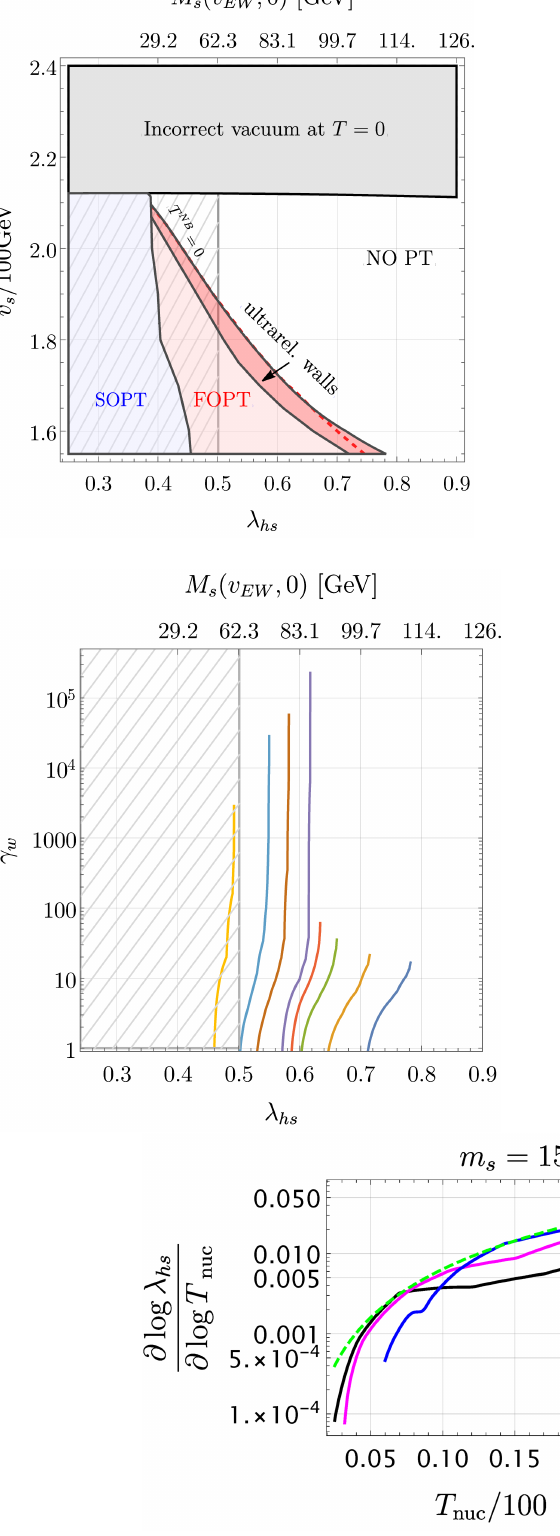
Figure 12 . Similar plots than in figure 1 and figure 3 for the value of m s = 150